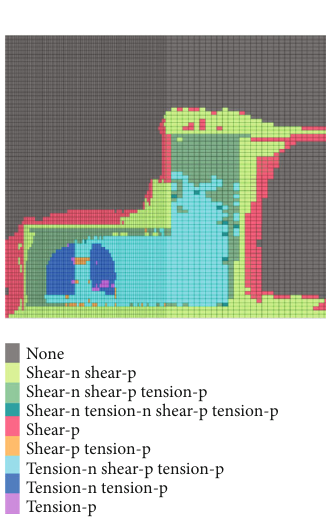
Figure 27: Development of plastic zone in mutative mining stope.